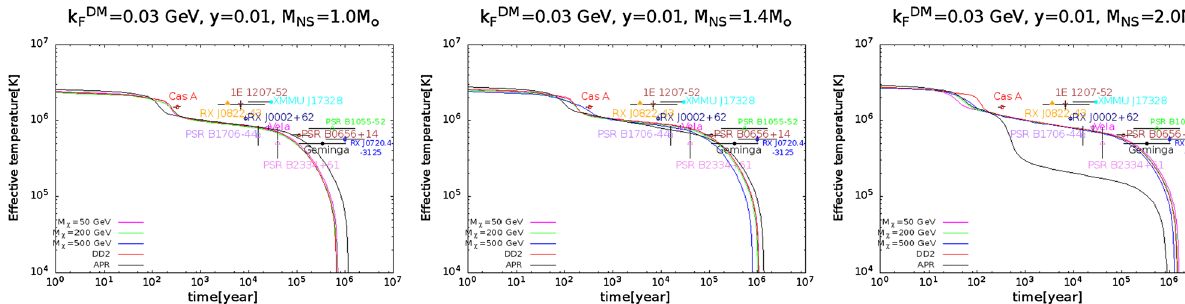
Fig. 13 Same as in Fig. 12 but for k DM